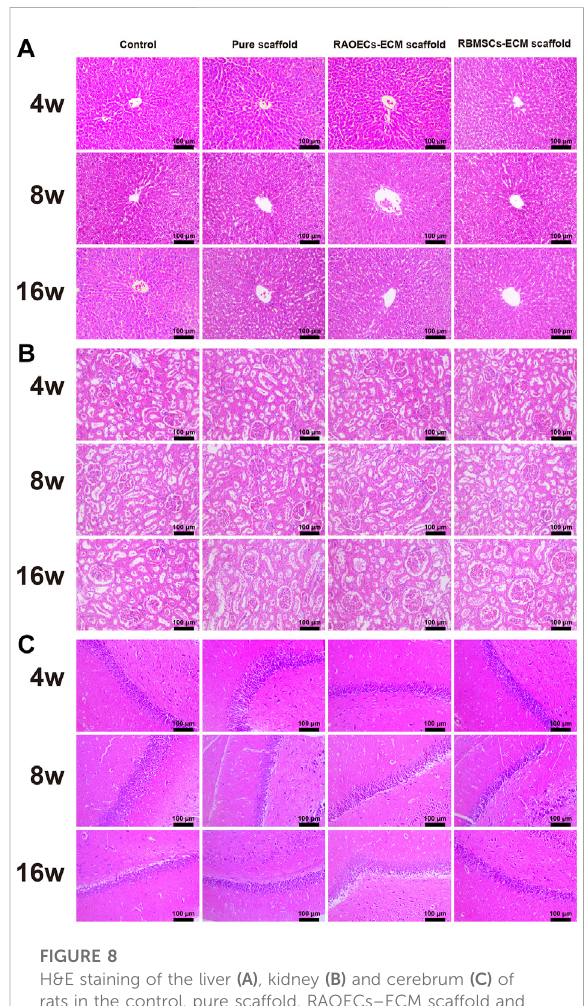
FIGURE 8 H&E staining of the liver (A) , kidney (B) and cerebrum (C) of rats in the control, pure scaffold, RAOECs – ECM scaffold and RBMSCs – ECM scaffold at 4, 8 and 16 weeks. No abnormalities were detected in any